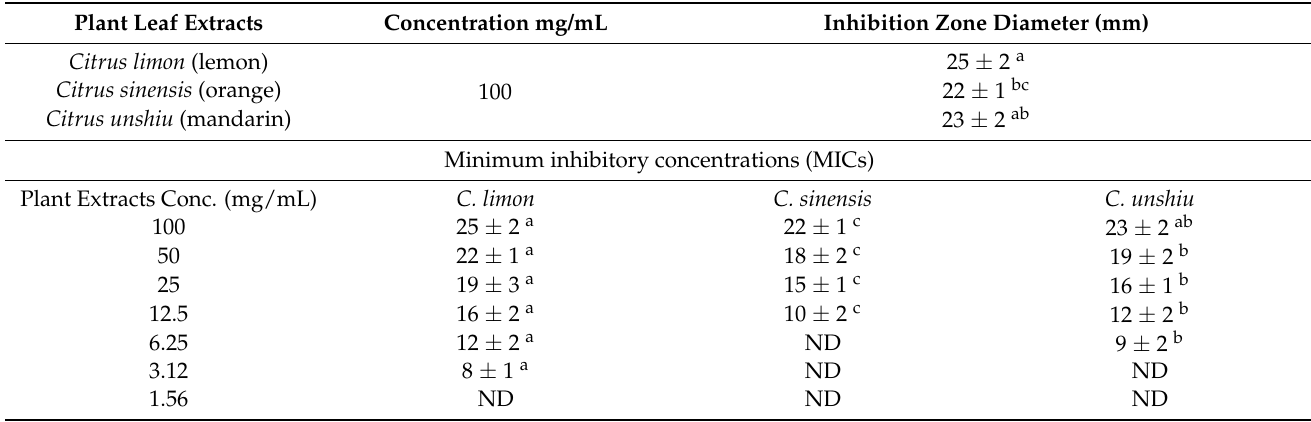
Table 8. Antibacterial activity and minimum inhibitory concentrations (MICs) of C. limon , C. sinensis, and C. unshiu leaf extracts against C. botulinum type E using an agar disk diffusion assay.